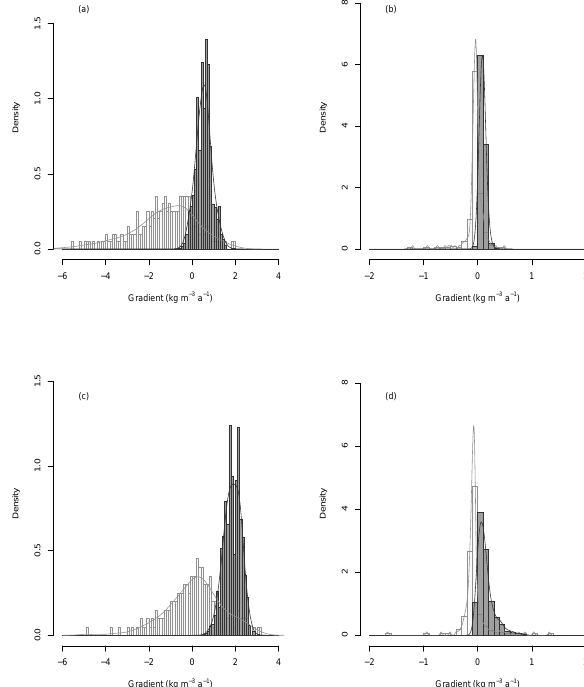
Fig. 7. Prior (light grey) and posterior (dark grey) distributions of the four value gradient set, b = (b N p ,b N n ,b S p ,b S n ) for regions north ( b N , top row) and south ( b S , bottom) of 77 ◦ N, and SMB less than zero ( b n , left column) and greater than or equal to zero ( b p , right). to avoid the difficult task of modelling the spatial correlation and variation of the